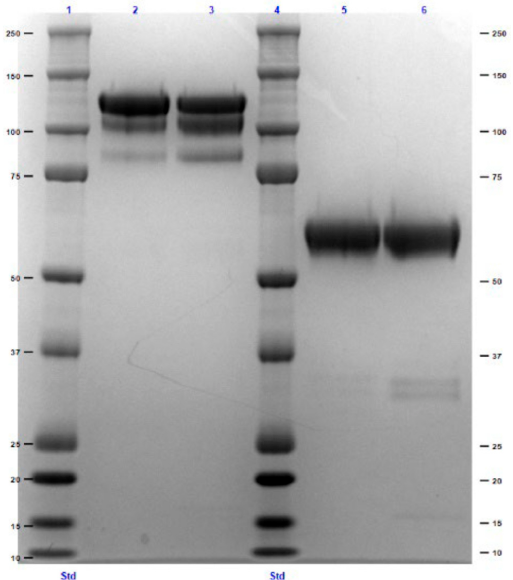
Figure A1. UncroppedCoomassie-stainedgel shownin Figure 2.